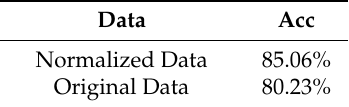
Table 3. Accuracy for the di ff erent